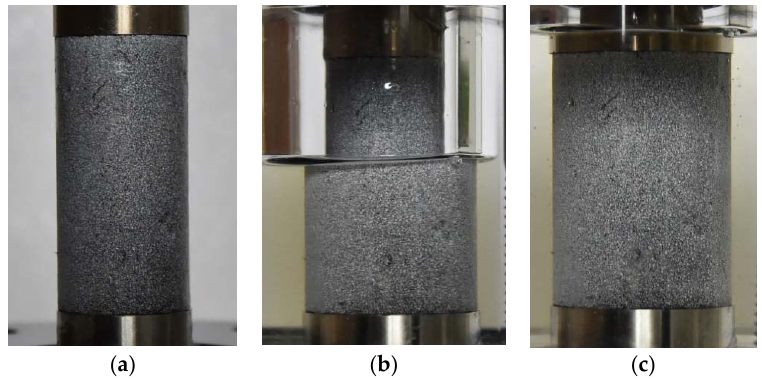
Figure 3. Photographs of the specimen showing distortion: ( a ) the empty cell; ( b ) the cell partly filled with oil; ( c ) the cell fully filled with oil.